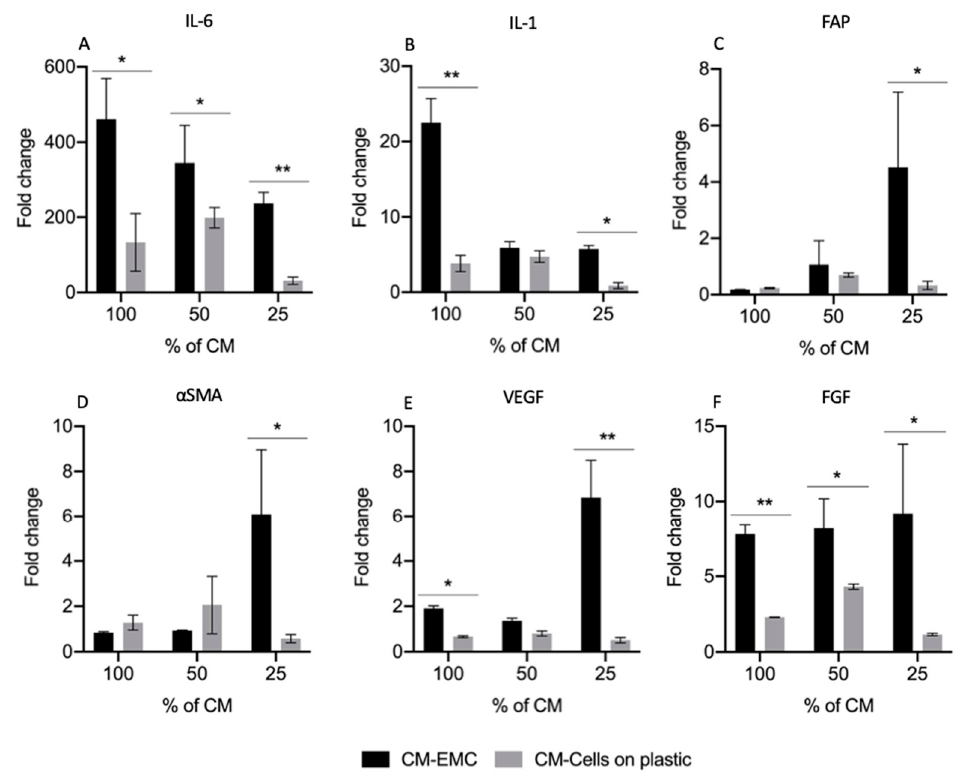
Figure 5. Different concentrations of conditioned medium from bladder-EMC cultures could induce two different phenotypes on fibroblasts. First was a pro-inflammatory phenotype with the upregulation of ( A ) IL-6 and ( B ) IL-1. Second was myofibroblast phenotype with the upregulation of ( C ) FAP, ( D ) α SMA, ( E ) VEGF, and ( F ) FGF. * Statistically significant p ≤ 0.05. ** Statistically highly significant p ≤ 0.01.